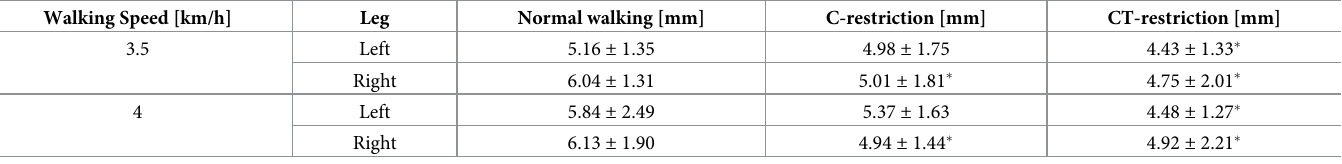
Table 4. MTC variability (IQR) among